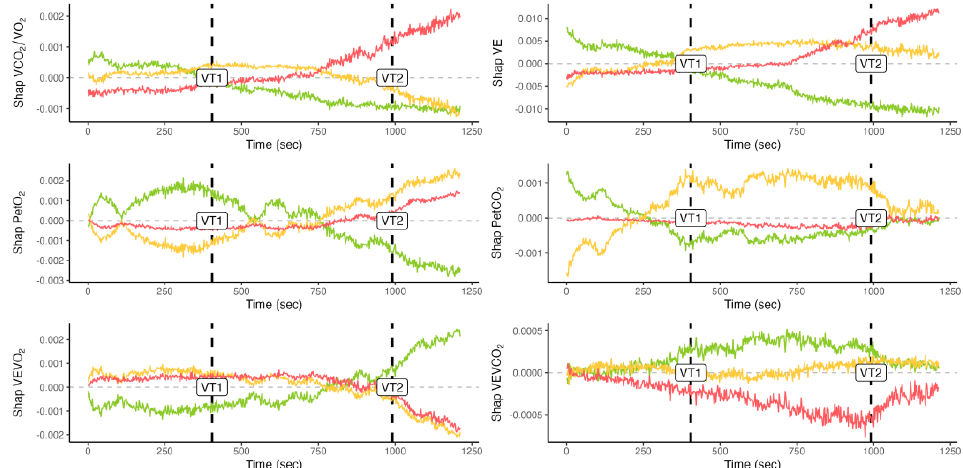
Figure 5. Shapley’s values for a representative individual and test. Colors are used to separate exercise intensity domains, i.e., moderate (green), heavy (yellow), and severe (red). Time is provided in seconds from the beginning of the test. Exercise thresholds detected by the neural network are also highlighted (VT1 and VT2).